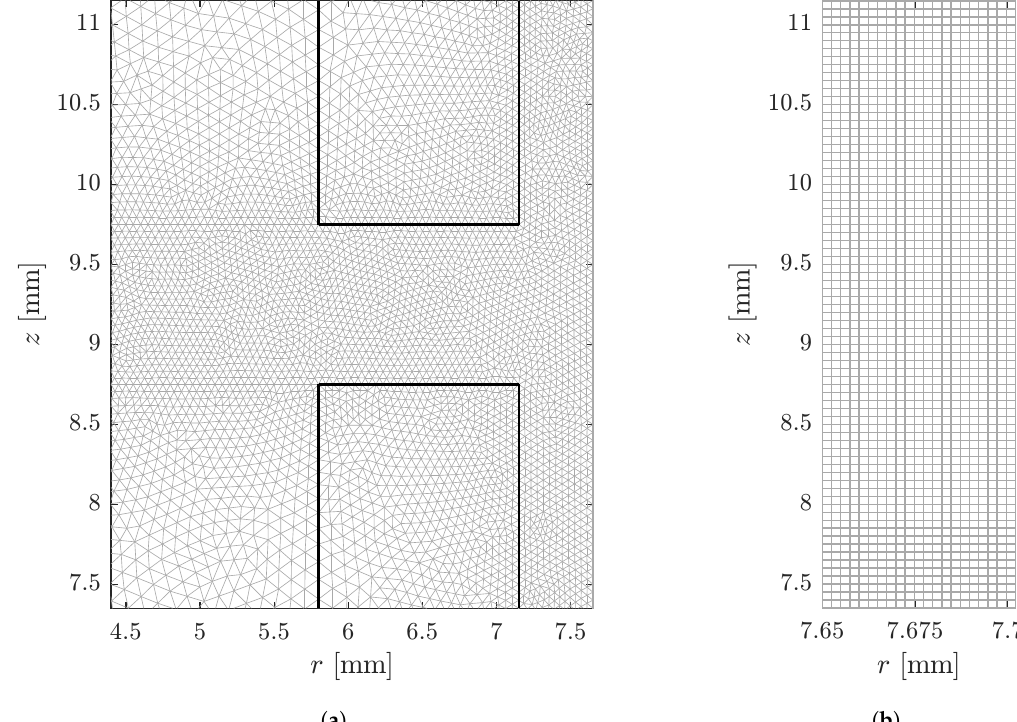
Figure 5. The densest FEM mesh considered in the convergence analysis (27,528 d.o.f.); ( a ) mesh in the non-conductive region ( b ) mesh in the conductive region near the outer